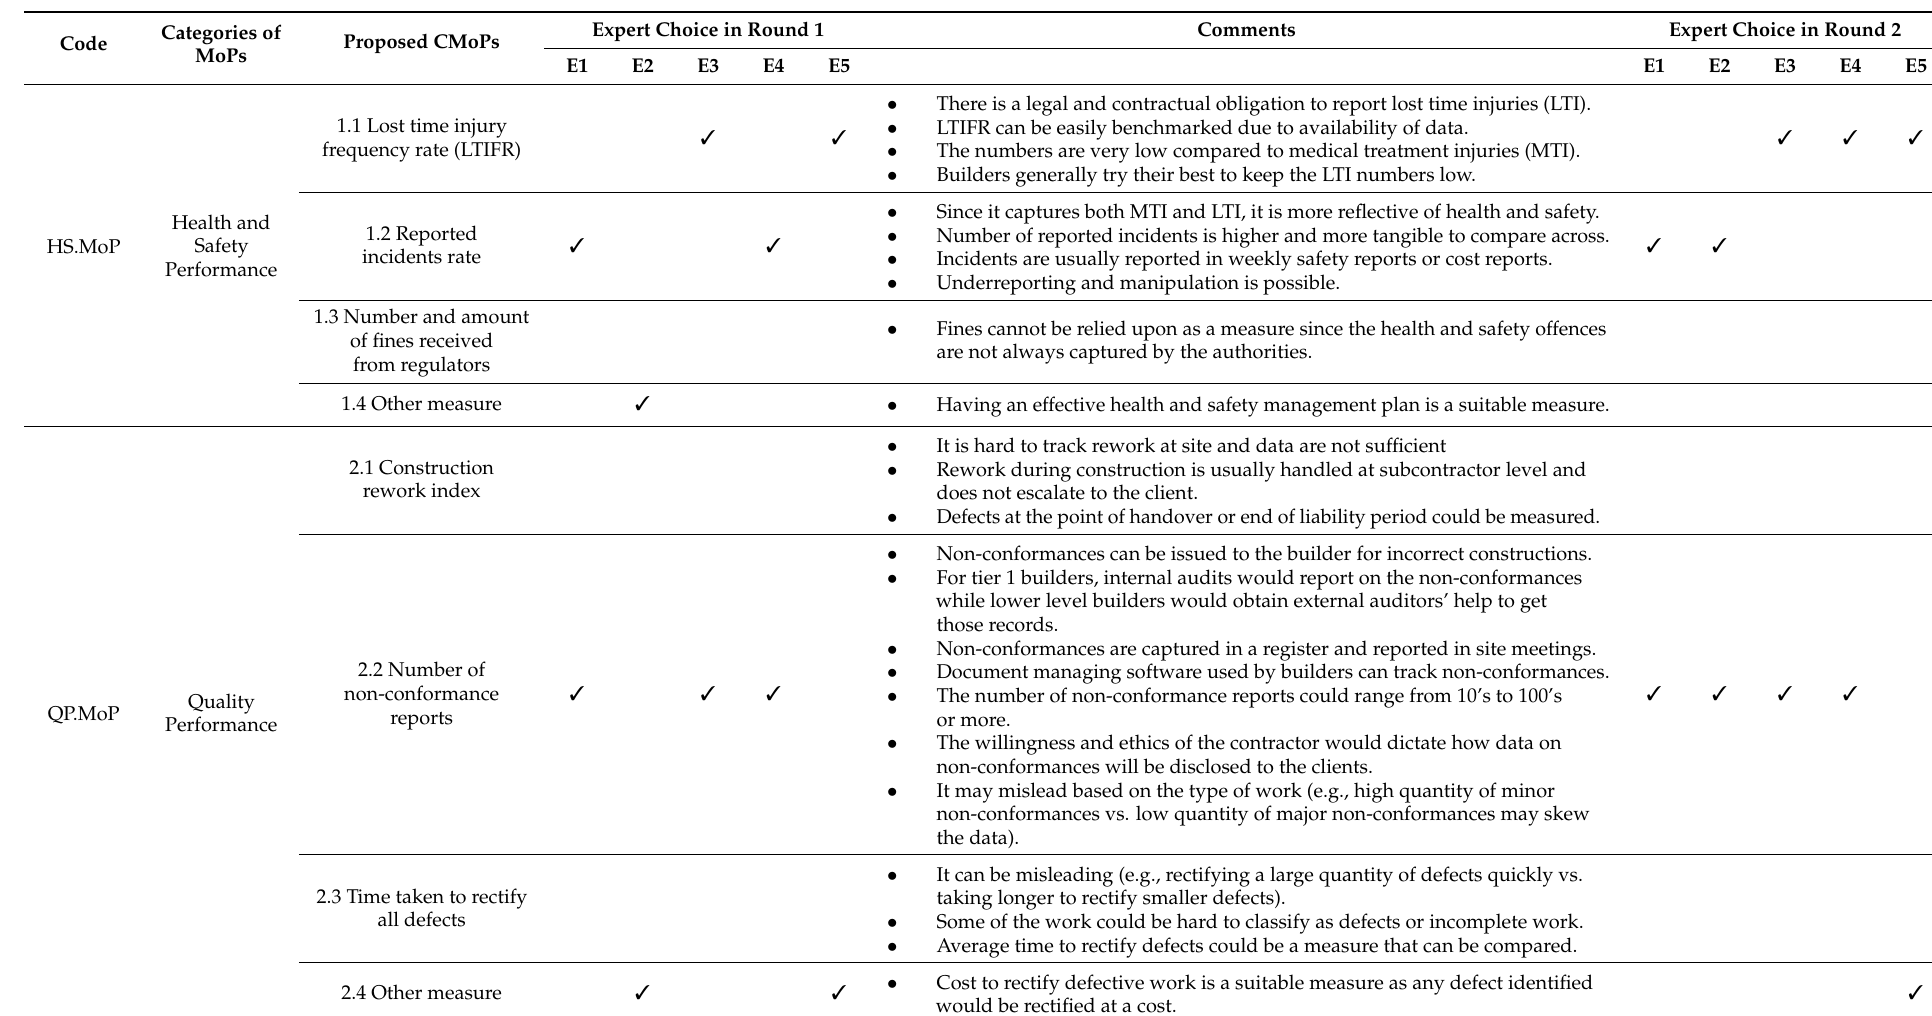
Table 4. Results of expert forum round 1 and round